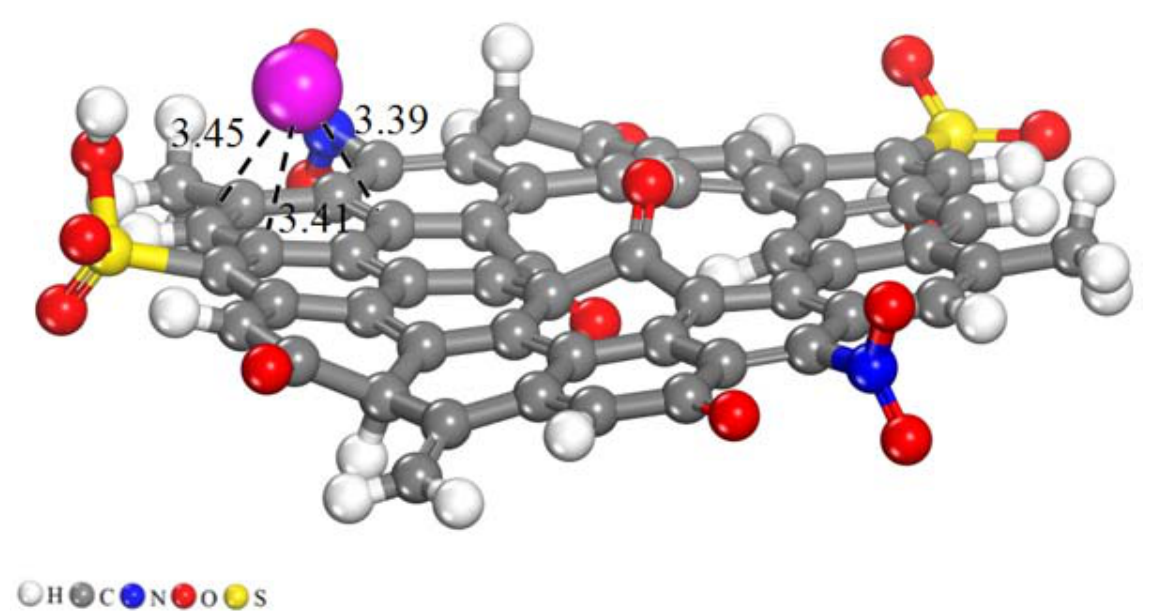
distances are in Å.